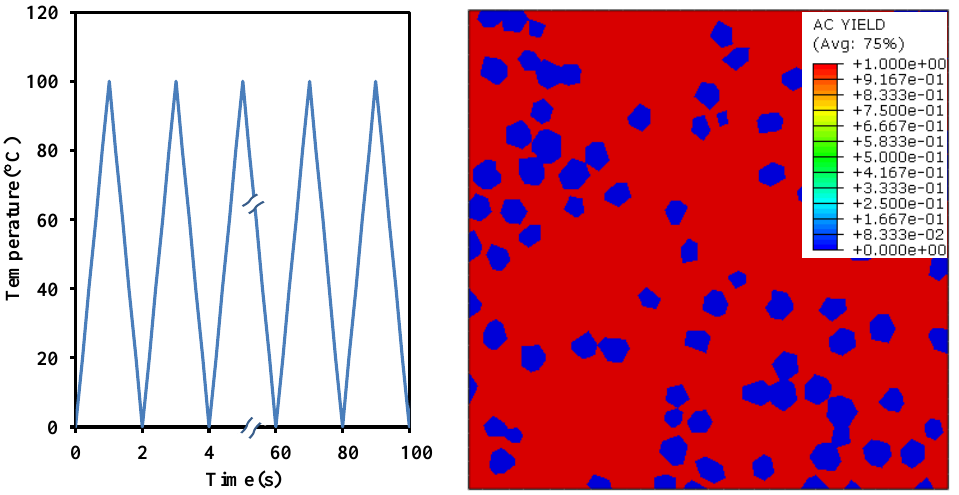
Figure 8. Case 4: Thermal boundary condition applied to all nodes (left), Contours of active yielding (right).